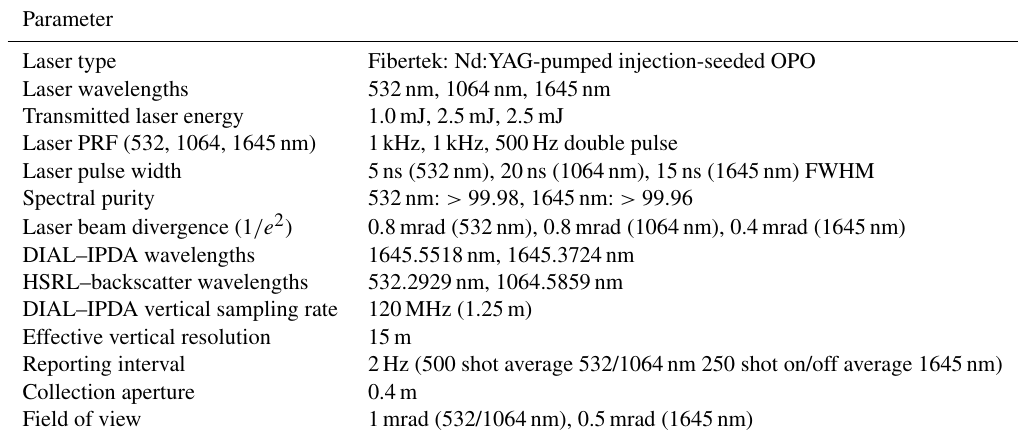
Table 1. HALO parameters during ACT-America 2019.